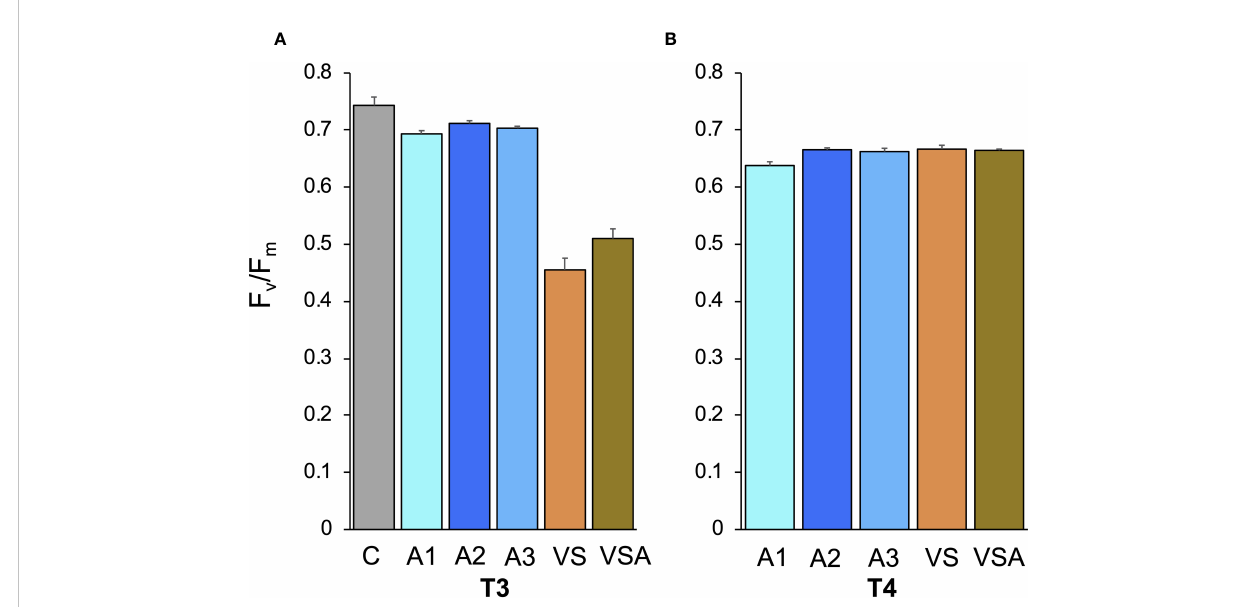
FIGURE 3 Mean values (± SE) of the maximum quantum yield of PSII (F v /F m ) of Ericaria amentacea seedlings; (A) at the end of laboratory culture (T3); (B) after 3 weeks of culture in the fi eld (T4). C (seawater, SW); A1 (SW with Algatron 2 mL L -1 ); A2 (SW with Algatron 4.5 mL L -1 ); A3 (SW with Algatron 9 mL L - 1 ); VS (SW with addition of von Stoch); VSA (SW with addition of von Stoch and Algatron 4.5 mL L -1 ). At T4 C-treatment tiles were free of seedlings.